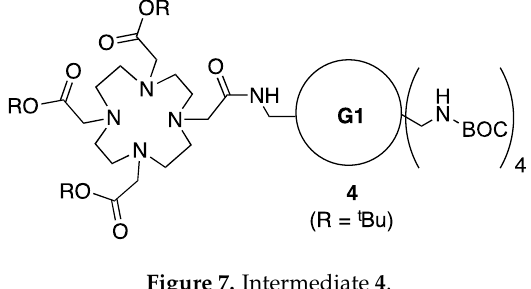
Figure 5. Intermediate 4 . Figure 7. Intermediate 4 .